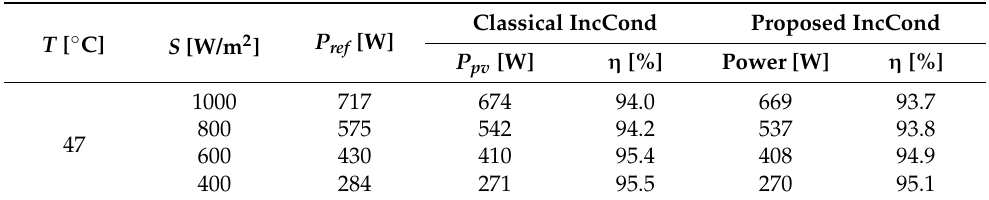
Table 6. Comparison between the proposed and the classical IncCond algorithms under steps of irradiance.